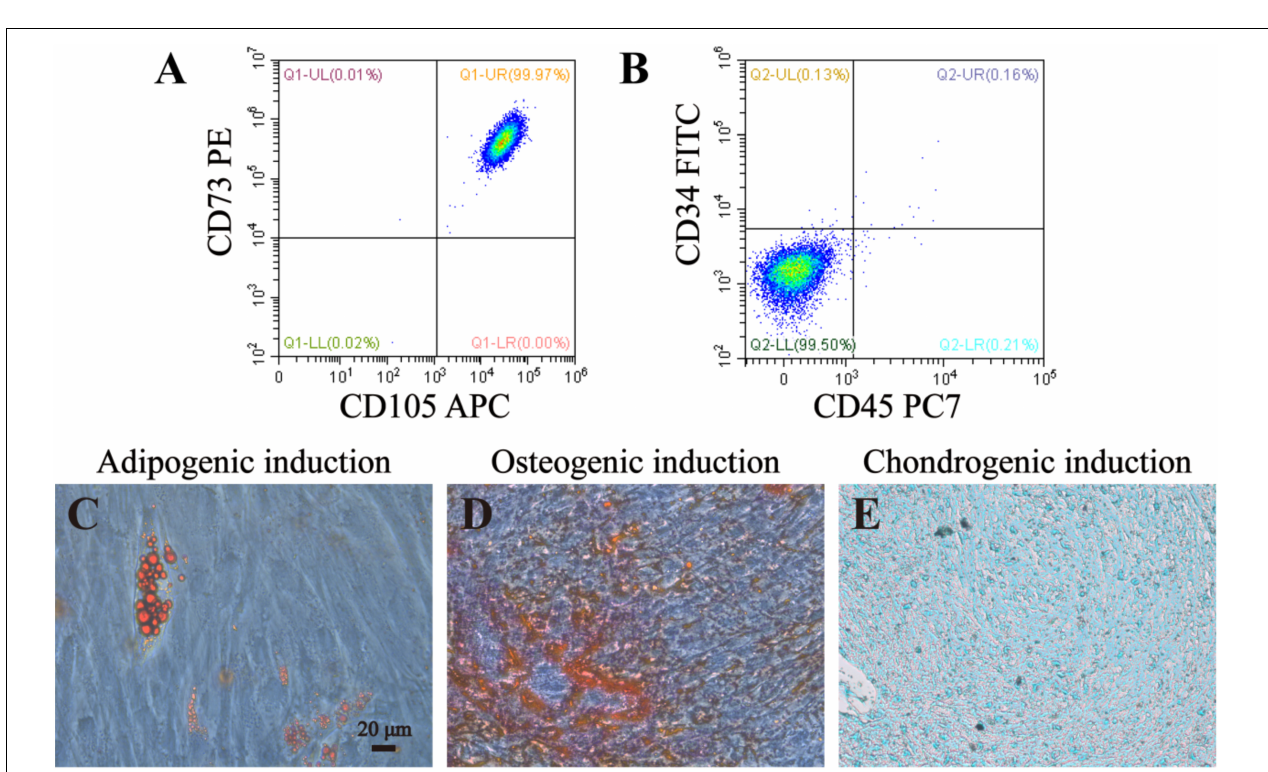
FIGURE 4 | Identification and lineage differentiation of DPSCs. (A,B) Flow cytometry confirmed that DPSCs isolated and cultured in present study positively expressed surface markers of mesenchymal stem cells (CD73 and CD105), and negatively expressed surface markers of hematopoietic stem cells (CD34 and CD45). (C–E) Multiple differentiation potency of DPSCs used in this study was assessed by osteogenic, adipogenic and chondrogenic experiments. Fat droplets (red in C ), calcified nodules (red in D ), and chondrocytes (blue in E ) were presented after 21 or 28 days inductions. Bar = 20 µ